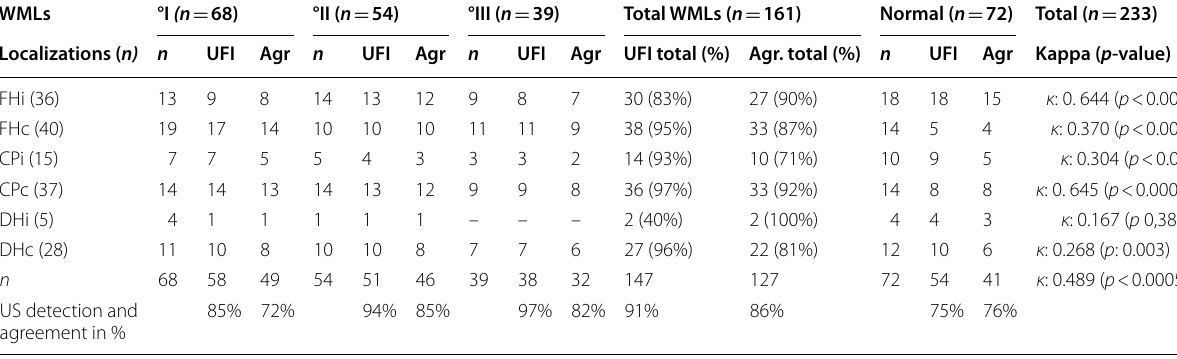
The numbers ( n ) are given in total and in percent (%) of ultrasound (US) detection and inter-rater agreement. WMLs white matter lesions, Loc localizations, UFI ultrasound fusion imaging, Agr agreement 2 raters, FHi frontal horn ipsilateral, FHc frontal horn contralateral, CPi central part ipsilateral, CPc central part contralateral, DHi dorsal horn ipsilateral, DHc contralateral dorsal